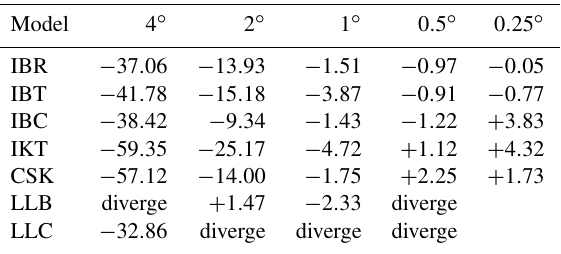
Table 5. Percentage change in kinetic energy for different models and resolutions after 50 days of integration from solid body rotation initial conditions with Earth’s bottom topography. “Diverge” means the simulation